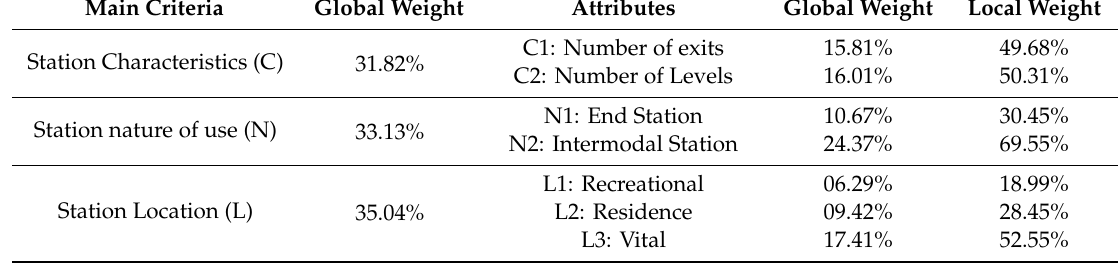
Table 12. Criticality Attributes Weights Obtained Using FANP.